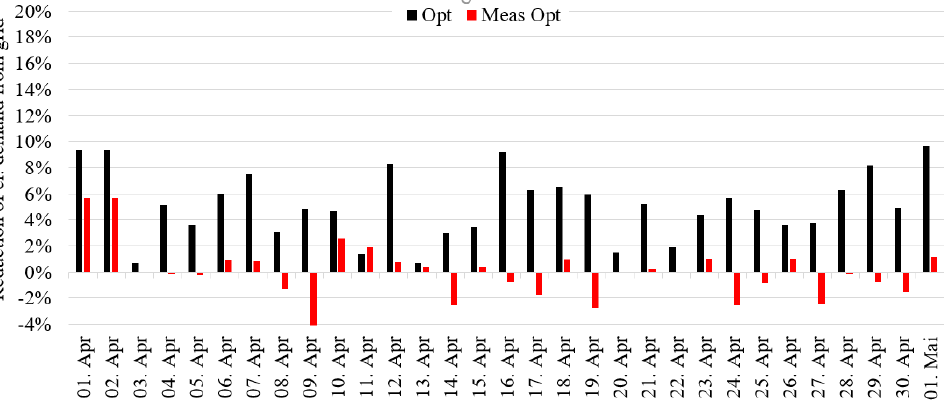
Figure 10. Daily optimization improvement for a building cluster with normal storage size for the month April.